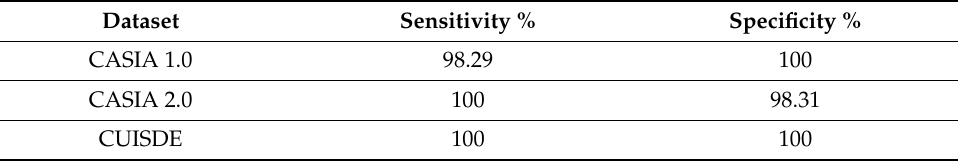
Table 4. Sensitivity and specificity of the proposed model over CASIA 1.0, CASIA 2.0, and Table 3. Confusion matrices of the proposed model over CASIA 1.0, CASIA 2.0, and CUISDE da- CUISDE taset.